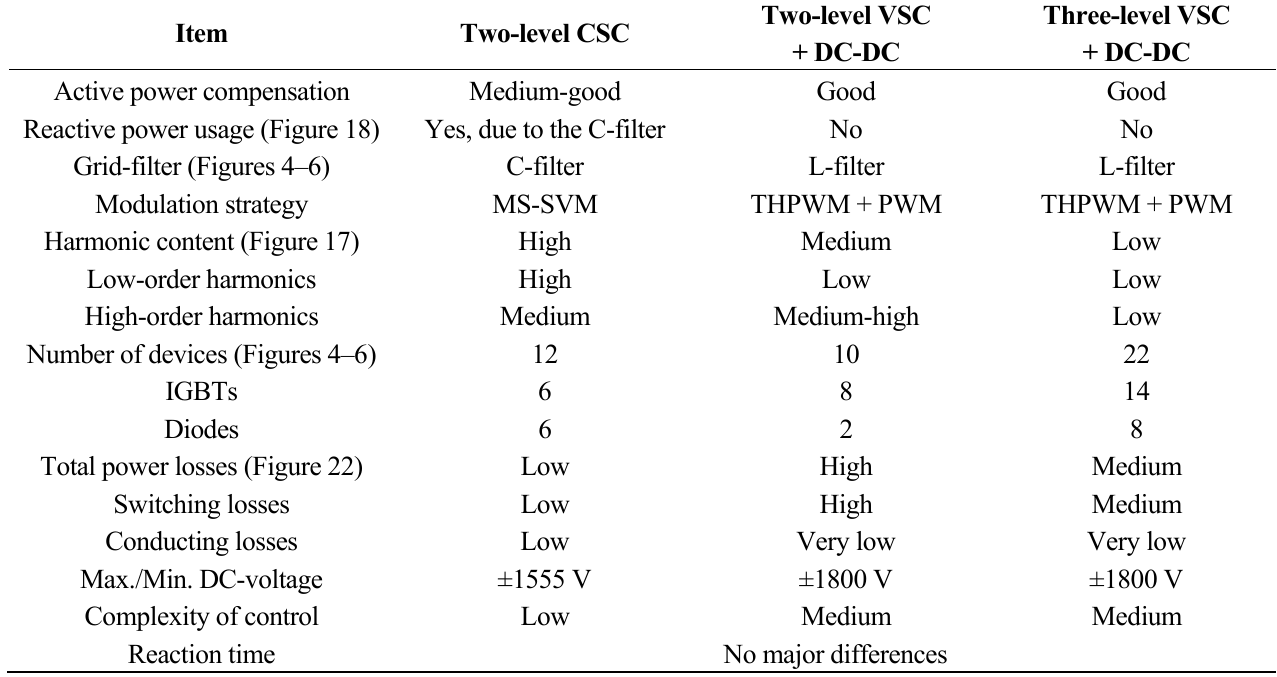
Table 5. Comparison table of the three